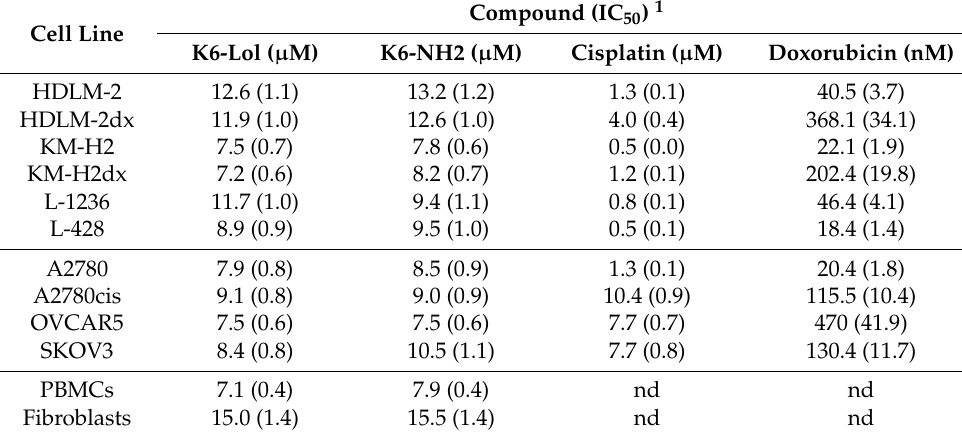
Table 1. Half-maximal inhibitory concentrations (IC 50 ) with the related standard deviation (SD) of the peptaibols K6-Lol, K6-NH2, the reference drugs cisplatin and doxorubicin: in HL cell lines HDLM-2, KM-H2, their doxorubicin-resistant clones KM-H2dx and HDLM-2dx, L-1236, L-428 cells; in OvCa cell line A2780 and its cisplatin-resistant clone A2780cis, OVCAR5 and SKOV3 cells; in human peripheral blood mononuclear cells (PBMCs) and human